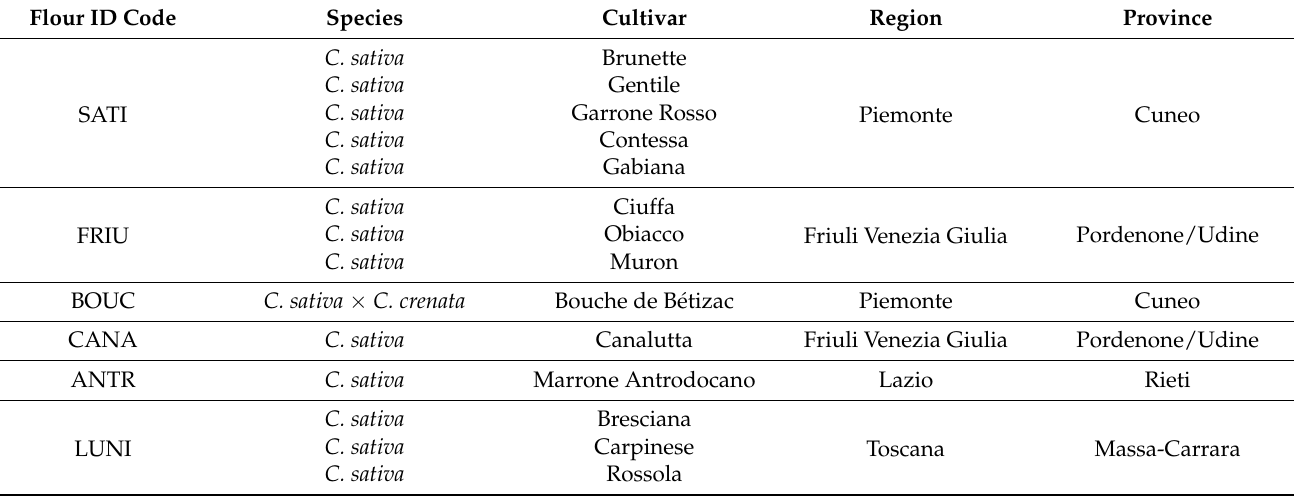
Table 1. Identification (ID) codes of the analysed chestnut flours. For each sample, the table shows the cultivars (and their origin) that compose the chestnut